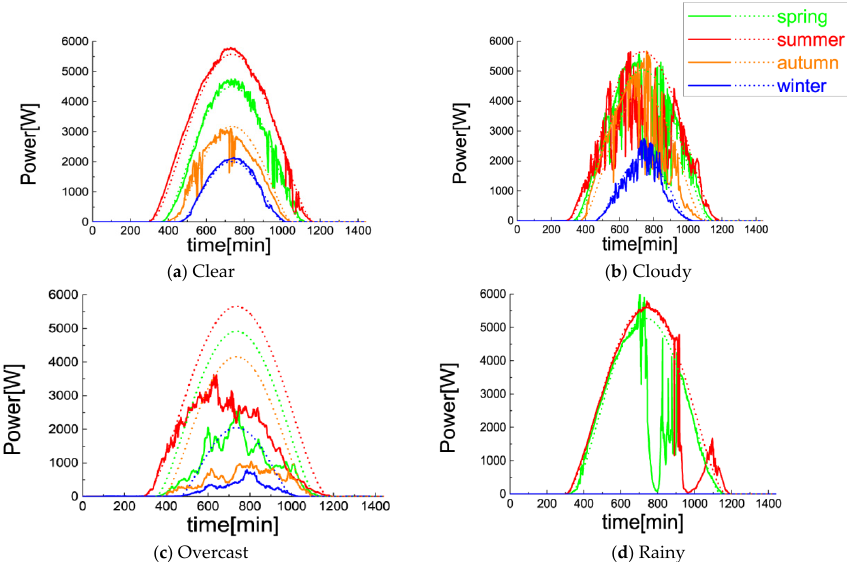
Figure 2. Output of a PV power plant during typical seasons and under typical weather conditions.